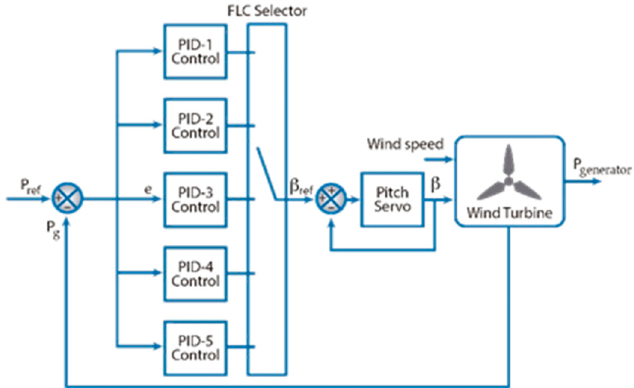
Figure 9. Selection of different proportional integral derivative (PID) controllers to obtain a steady state response in different operating ranges of the system [51].